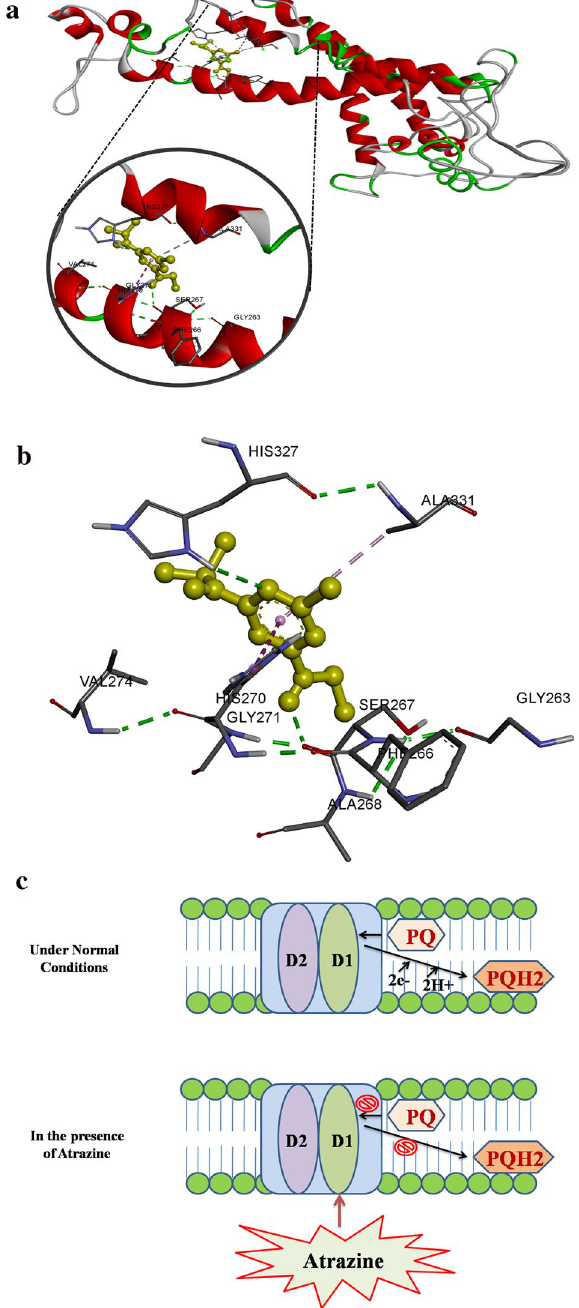
Figure 7. Molecular docking image of Atrazine binding with D1 protein. ( a ) Atrazine is represented as a ball and stick model while D1 protein is shown as a ribbon. ( b ) 2-Dimensional view of various amino acid residues interacting with atrazine through different non-covalent interactions. ( c ) Proposed mechanism of atrazine toxicity in C.